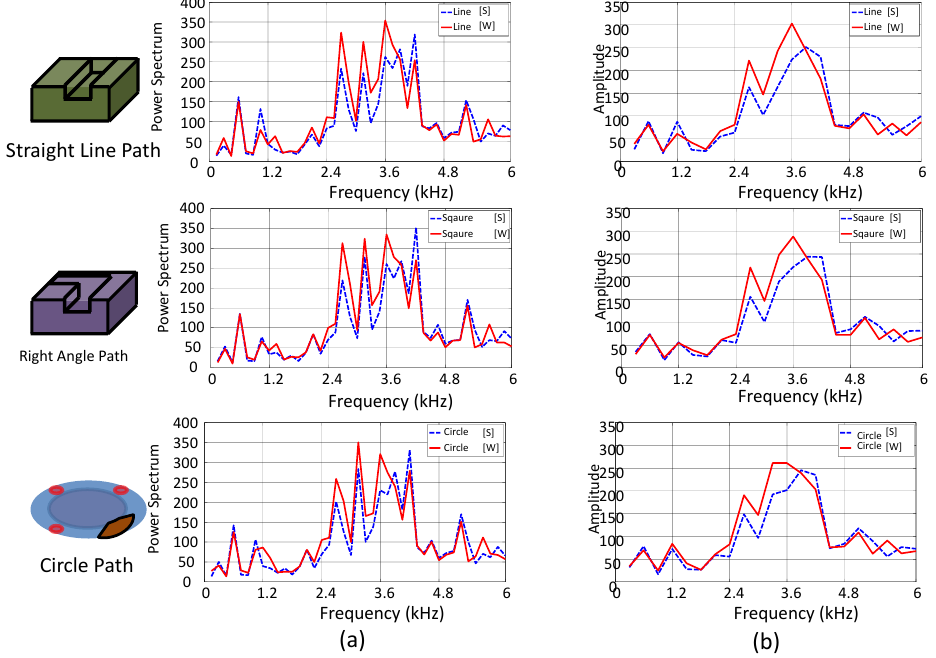
Figure 15. Frequency domain vibration signal with various bandwidth sizes: ( a ) 150 Hz; ( b ) 300 Hz (X-direction).